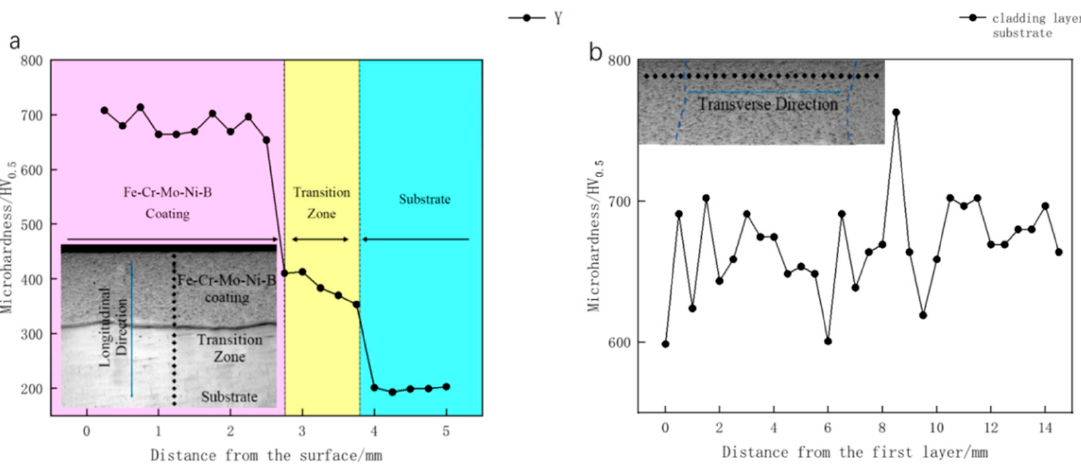
Figure 10. Microhardness of the Fe–Cr–Mo–Ni–B coating: ( a ) longitudinal section; ( b ) cross-sec- tion.